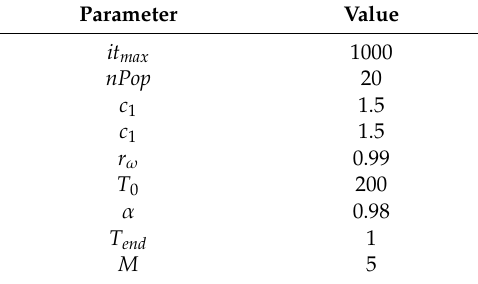
Table 7. Parameters of LSHA.